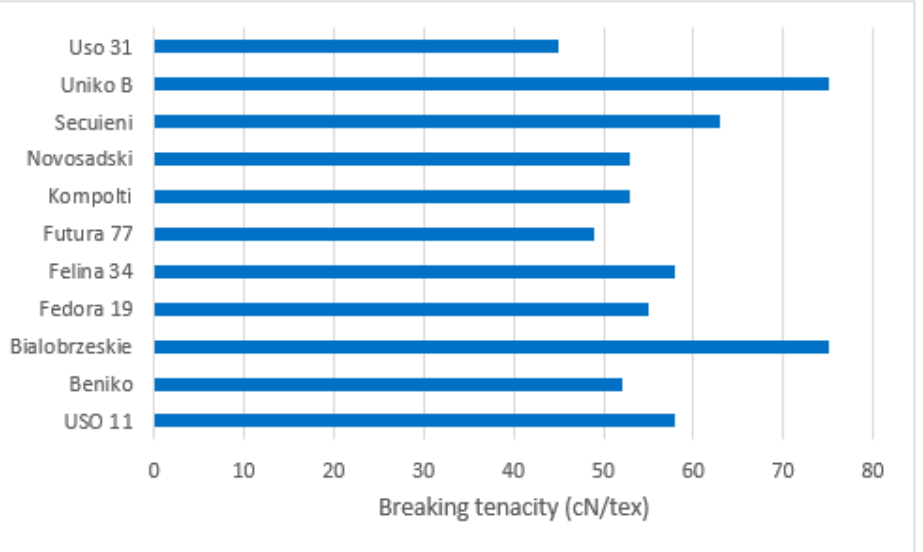
Figure 14. Breaking tenacity of the fibres (cN/tex) measured for 12 fibre samples of each cultivar in 1996, based on [48].